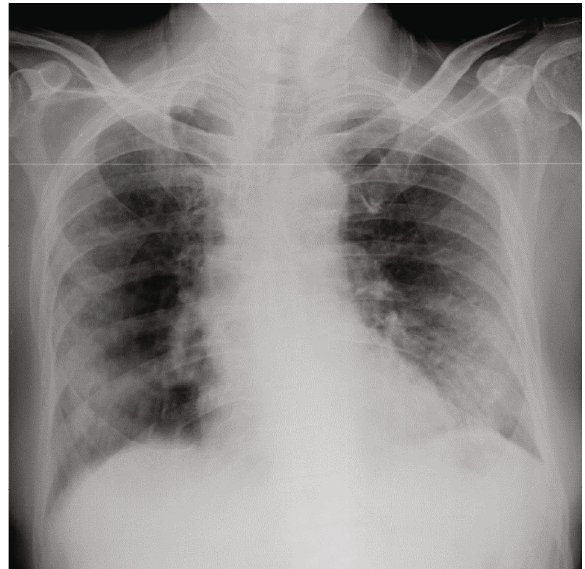
Figure 7: A chest radiograph of case 4 at the time of presentation with silent hypoxia showing bilateral air space opaci fi cation.